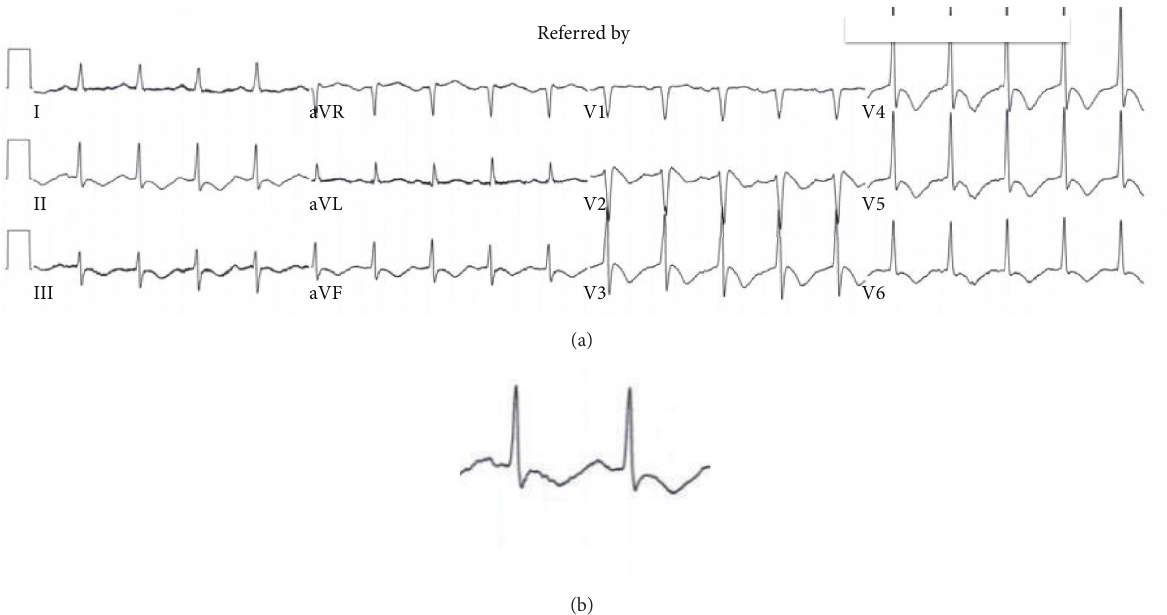
Figure 4: (a) After TdP, progressive T wave inversion and QTc prolongation of 691ms. (b) Close-up of lead